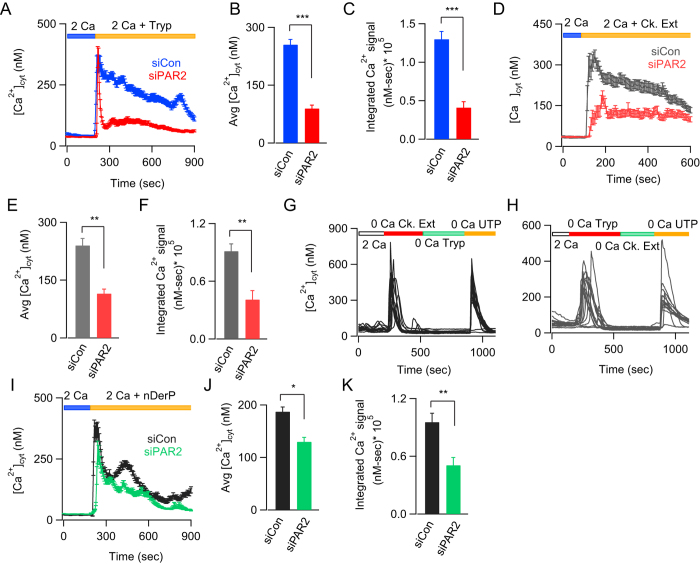
Cockroach and dust mite allergens evoke Ca2+ signals through PAR2 activation.(A–C) The PAR2 agonist type IX trypsin (50 nM) mobilizes [Ca2+]i in BEAS-2B cells. This [Ca2+]i elevation is suppressed by siRNA knockdown of PAR2. (B). Summary of the average cytosolic [Ca2+] rise 150 seconds after addition of trypsin. Summary of the integral Ca2+ signal following application of trypsin. (D–F) Ca2+ responses to cockroach allergen (8 μg/mL) in cells treated with siControl or siPAR2. (E) Summary of the average [Ca2+] rise 100 seconds after addition of cockroach extract. Summary of the integrated Ca2+ signal following application of the extract. (G,H) Paired application of the PAR2 agonist trypsin and cockroach allergen shows that prior activation of PAR2 by trypsin diminishes the subsequent allergen response and vice versa. Subsequent response to a non-PAR2 agonist, UTP, is unaffected suggesting that the lack of response in the paired application is not due to depletion of ER-stores but rather due to receptor desensitization. (I–K) Response to dust mite allergens is partially inhibited by knockdown of PAR2. Mean ± SEM of 21–43 cells, 2 experiments. *P < 0.05, **P < 0.01; Tryp, trypsin.